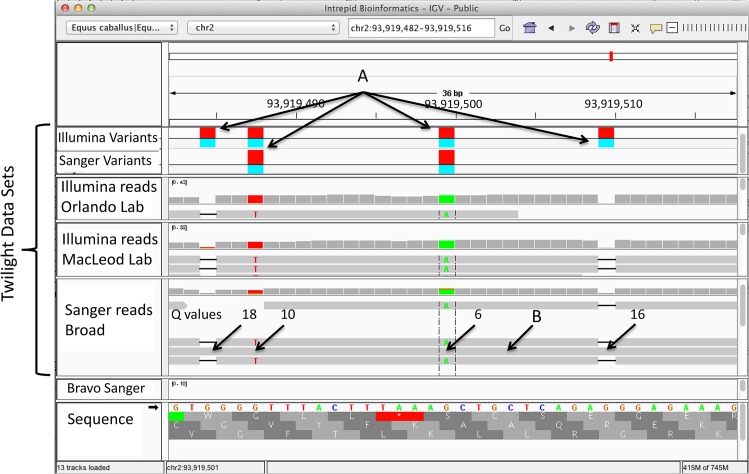
Incorrect Base Assignments.An example of incorrect base assignments. A) Variants (indicated by the red shading) that are called homozygous (indicated by the turquois shading) differences measured by the UnifiedGenotyper in both the Illumina and Sanger datasets are shown here. In B), it is demonstrated that a single low quality Sanger read was used as the basis for the consensus sequence in this region. The UnifiedGenotyper, however, ignores this read due to the low phred quality scores in the region. The phred based quality scores are indicated for the 4 miscalled bases. The corresponding NCBI Trace Archive Trace Name and TI# are G836P5757RI23 and 1325049864 respectively, with bases 594–630 as the region of interest. This region may be viewed in IGV at http://dx.doi.org/10.13013/J6VD6WCM. The link will download a JNLP file that webstarts IGV centered on region of interest. Bases within the reads that agree with the reference are not rendered.